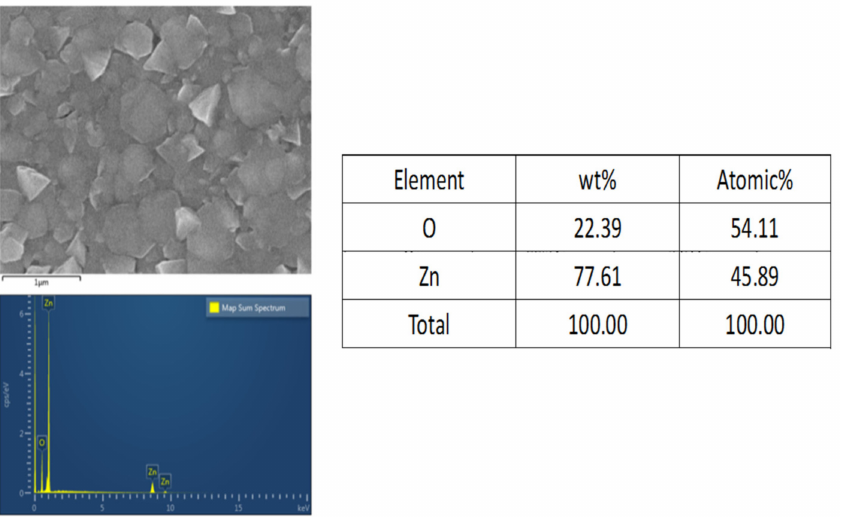
Figure 9. EDS analysis results of sputtered